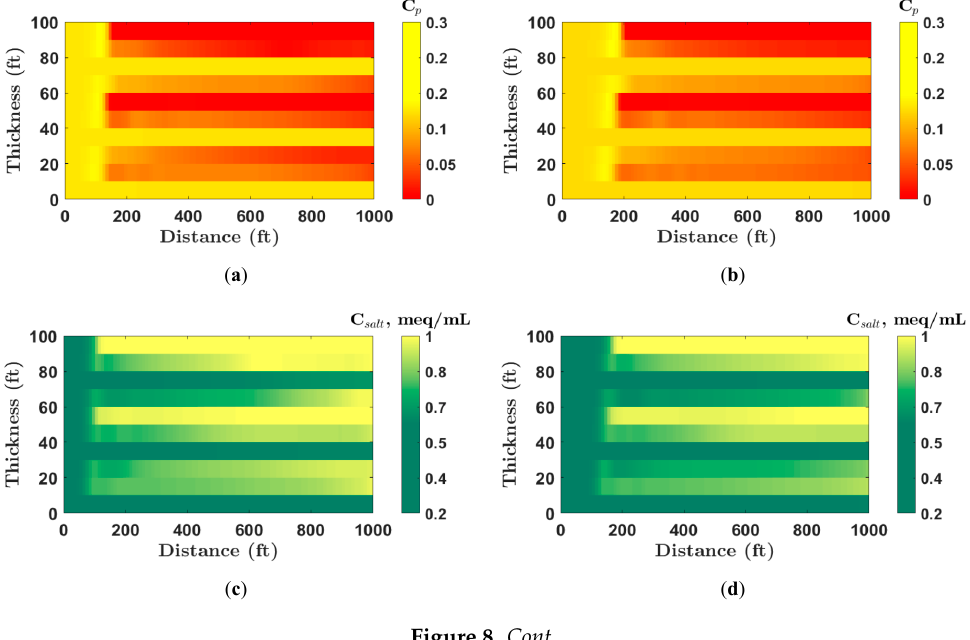
Figure 7. Polymer concentration in wt.% ( a , b ), salinity ( c , d ), and aqueous phase viscosity ( e , f ) profiles for the test case using the compositionally-tuned slug-based process at t D = 1.3 ( a , c , e ) and t D = 1.7 ( b , d , f ).